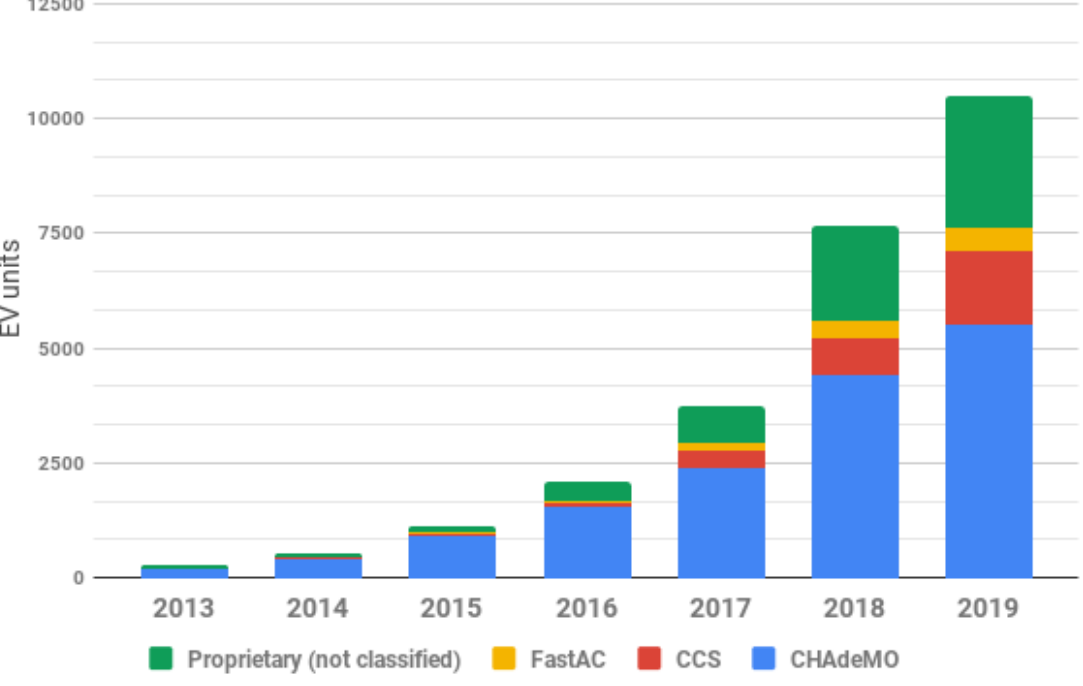
Figure 1. Number of EVs equipped with charging category